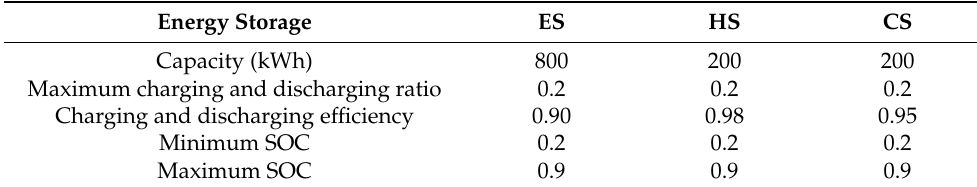
Table 4. The equipment parameters of energy storage.